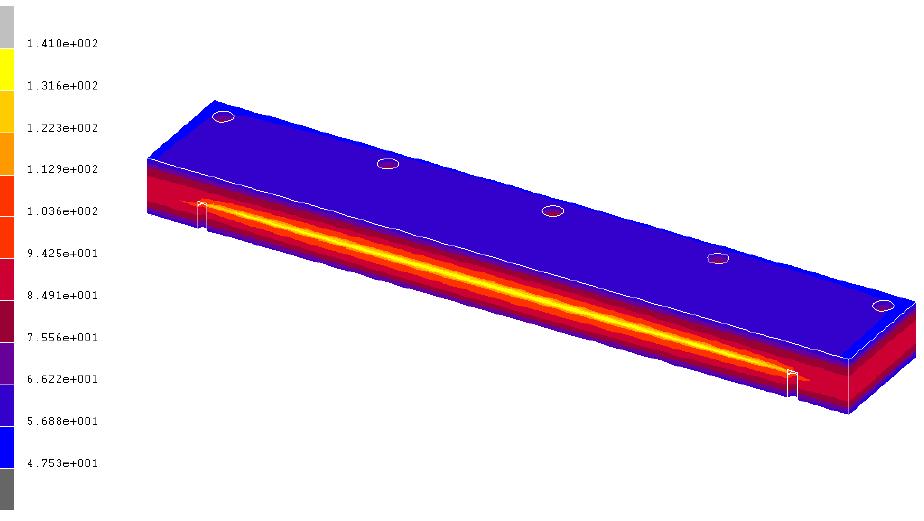
◦ C) distribution at the end of the preheating. Figure 8. Temperatures (°C) distribution at the end of the preheating. Figure 8. Temperatures (